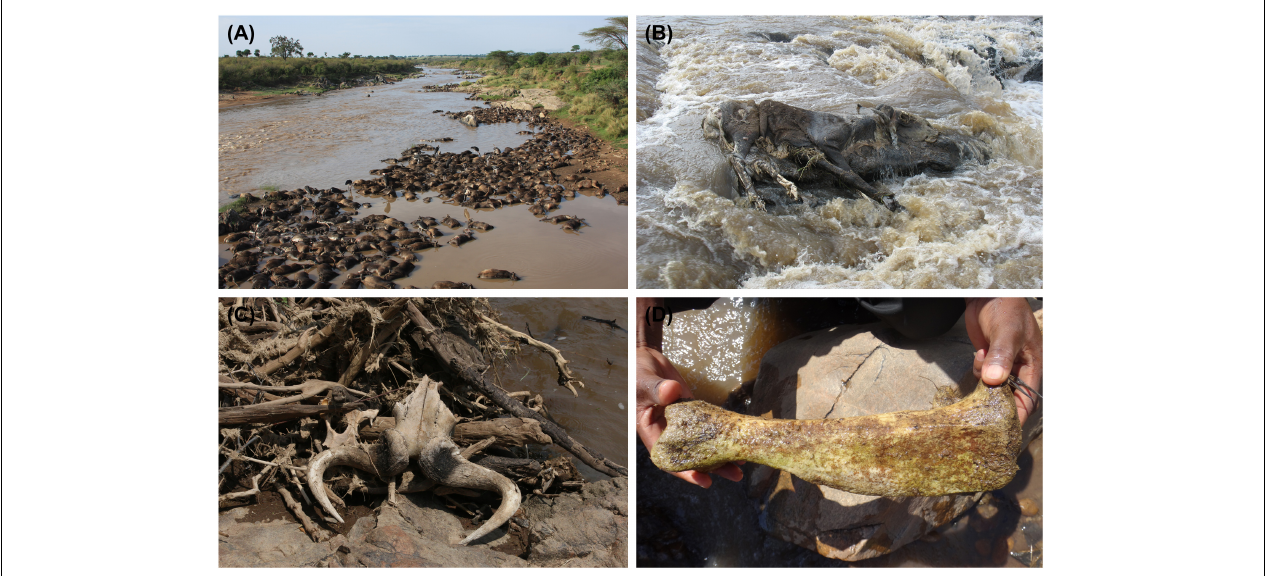
FIGURE 2 | The ontogeny of wildebeest bones in the Mara River, Kenya. (A) Annual mass drownings result in the input of a mean of 6,250 carcasses per year. (B) Carcass soft tissue decomposes over weeks to months, but bone persists in the river for decades. (C) Bones can continue to leach out phosphorus even after a prolonged period in the river. (D) Biofilms that grow on bones are higher in chl a and organic matter (OM) than biofilms on rocks, and they provide an important food source for macroinvertebrates and